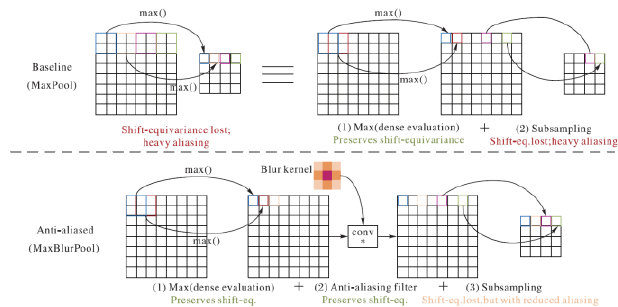
Figure 5. Anti-aliased max-pooling